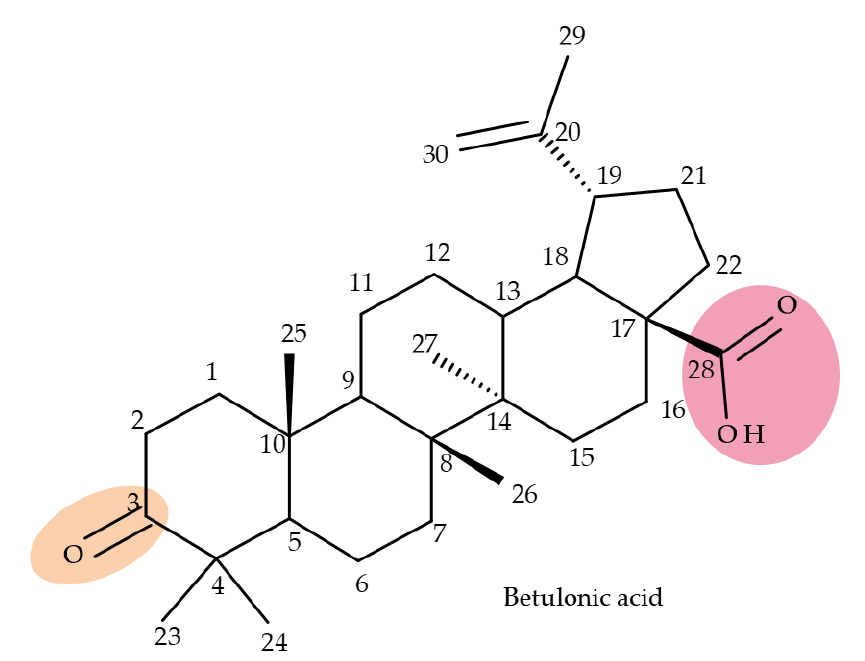
Figure 6. Frequent targets for the derivatization of betulonic acid.